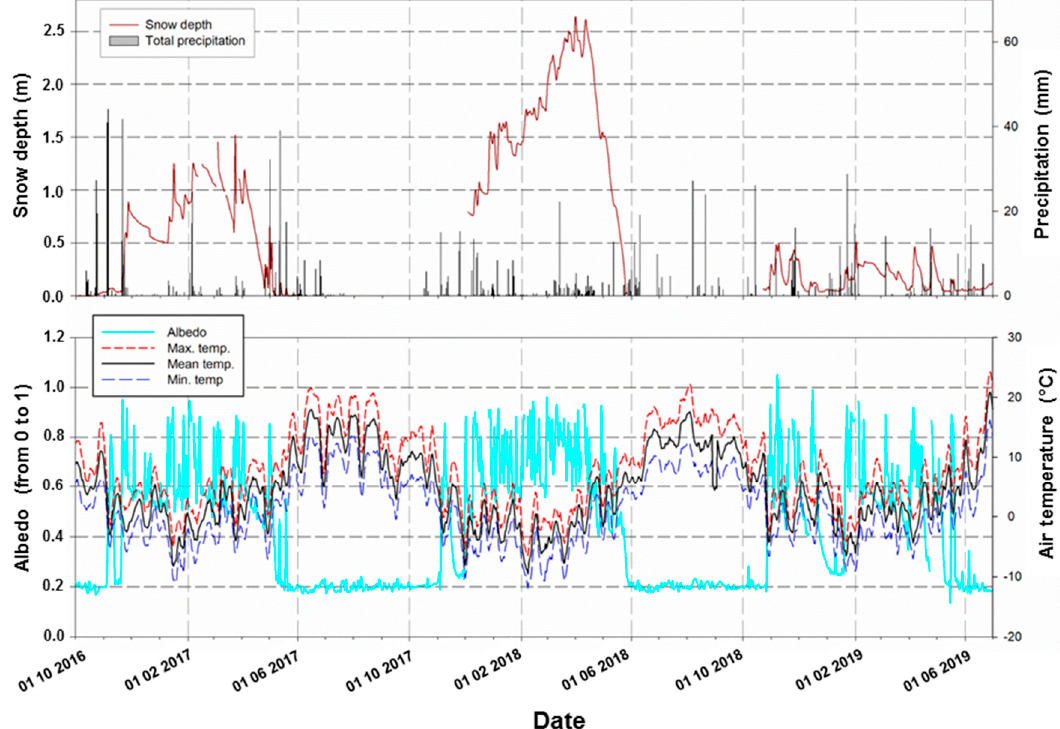
Figure 2. Temporal evolution of main meteorological variables observed at the automatic weather station of Izas Experimental Catchment. Upper panel shows, the snow depth and total precipitation observed during the study period. Bottom panel shows, mean, maximum, and minimum air temperature (averages in 5 days intervals) and surface albedo.